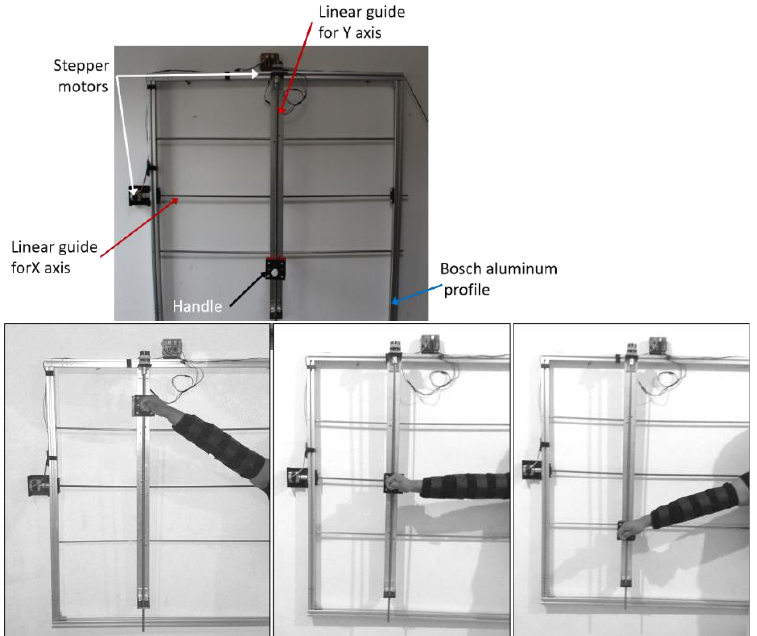
Figure 21. Physical prototype of the shoulder rehabilitation machine.